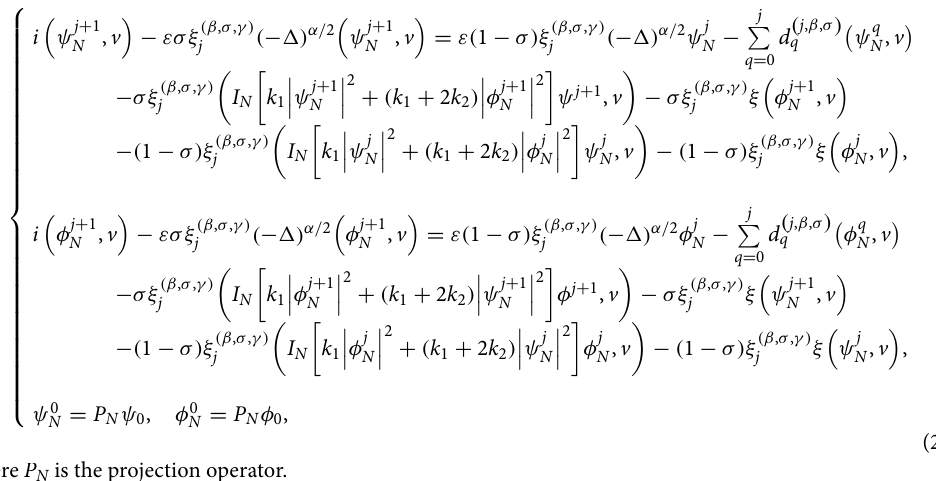
Algorithmic implementation. Via the hypergeometric function, Jacobi polynomials can be represented 36 , ( 1 and x 1, 1 ) for α , β > − ∈ −